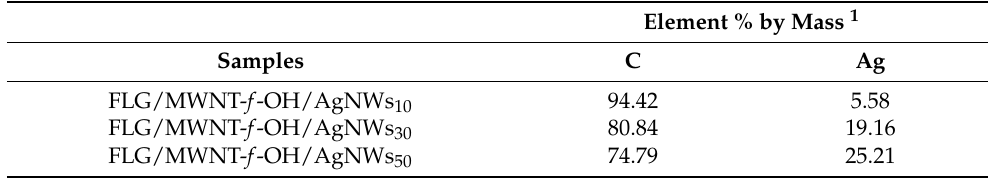
Table 1. EDS analysis of the FLG/MWNT- f -OH/AgNWs